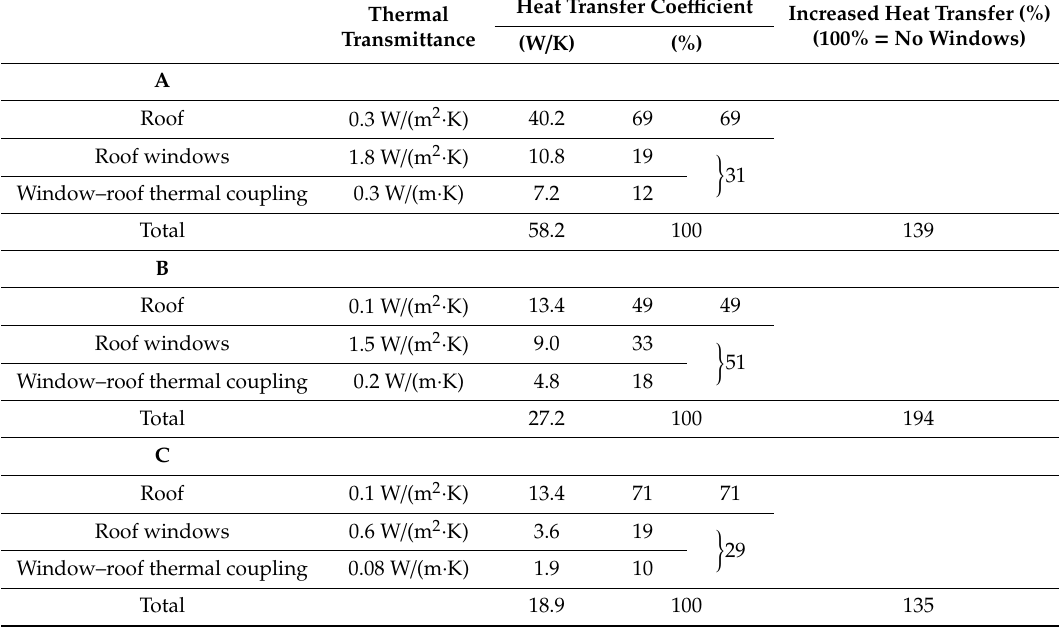
Table A1. Examples of the distribution of transmittance heat loss for a pitched roof (total area 140 m 2 ) of a family house with six roof windows (6 × 1.0 m 2 ). Alternative A corresponds to a typical solution around the year 2000, alternative B corresponds to a passive house quality roof with traditional roof windows, and alternative C corresponds to a passive house quality with high-performance